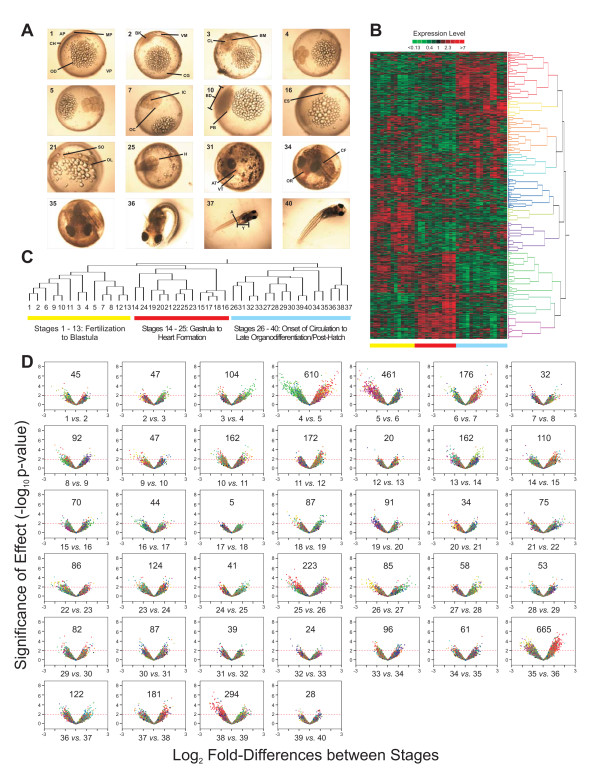
Stages and patterns of gene expression during development. A. Key stages during F. heteroclitus development. Stages (S) are in the upper left of each embryo image. S1, unfertilized egg. S2, 1 cell stage. S3, 2 cell stage. S4, 4 cell stage. S5, 8 cell stage. S7, 32 cell stage. S10, early blastula. S16, pre-mid gastrula. S21, 3-4 somites. S25, onset of circulation. S31 and S34, growth and organodiffertiantion. S35, pre-hatching. S36, hatching. S37, growth. S40, initiation of larval stage. (See Additional Files 1 and 4). AP-animal pole; AT-atrium; BD-blastoderm; BK-blastodisk; BM-blastomere; CF-caudal fin; CG-cortical granules; CH-chorion; CL-cleavage; ES-embryonic shield; H-heart; IC-inner cells; MP-micopyle; OC-outer cells; OD-oil droplet; OL-optic lobe; OR-oral cavity; PB-periblast; SO-somite; VM-vitelline membrane; VP-vegetal pole; VT-ventricle; Y-yolk. (For full atlas, see Additional Files 1, 2 and 4). B. Hierarchical clustering of 6,551 genes (95.5% of 6,857) that changed significantly between any two stages (p < 0.01). Each row represents one gene and each column represents one of forty developmental stages. Clusters of genes with similar expression patterns are shown on the right (gene tree). Red indicates high expression levels and green represents low expression levels. C. Hierarchical clustering of forty developmental stages based on shared gene expression patterns. Three majors clusters are colored yellow, red and blue and correspond to gene expression patterns. D. Pairwise differences between adjacent stages of F. heteroclitus development. Significances of differences as - log10(p-values) are plotted against log2 differences in expression of adjacent stages. - log10(p-values) range from 0 to 8 and log2 differences in expression range from -3 to 3 (-8-fold to 8-fold differences in expression). Numbers of significant genes (p < 0.01) that differ between stages are shown. Colors in these plots correspond to the colors of the gene tree in 1B.